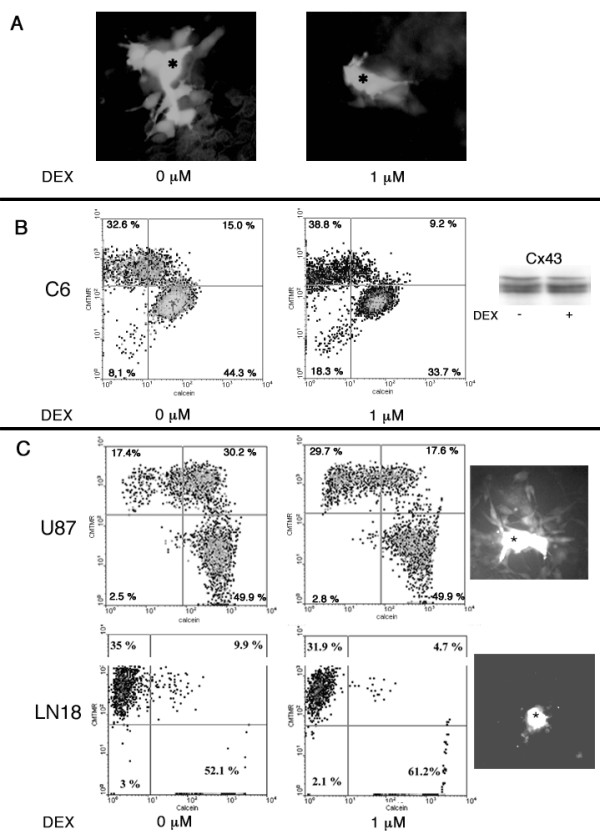
Effect of dexamethasone on gap junction intercellular communication. (A) Appearance of confluent cultures of C6 cells after iontophoresis of Lucifer Yellow in one single cell (*) in the absence (left) or presence (right) of dexamethasone (DEX). Photomicrographs are representative of the typical appearance of such injected cells. (B) FACS analysis of calcein dye transfer between rat C6 cells in the presence (right) or absence (left) of DEX. The GJIC is directly correlated with the percentage of CMTMR+/Calcein+ cells (upper right quadrants, see text for details). This experiment is representative of 3 independent experiments each performed on 10,000 cells. A Western blot of Cx43 in C6 cells is shown (left: control conditions, right, DEX treatment. See text for details) (C) FACS analysis of calcein dye transfer between human U87 (above) and LN18 (below) cells in the presence (right) or absence (left) of DEX. The rightmost pictures illustrate the basal GJIC of both cell types in confluent cultures after iontophoresis of Lucifer Yellow in a single cell (*, control conditions).